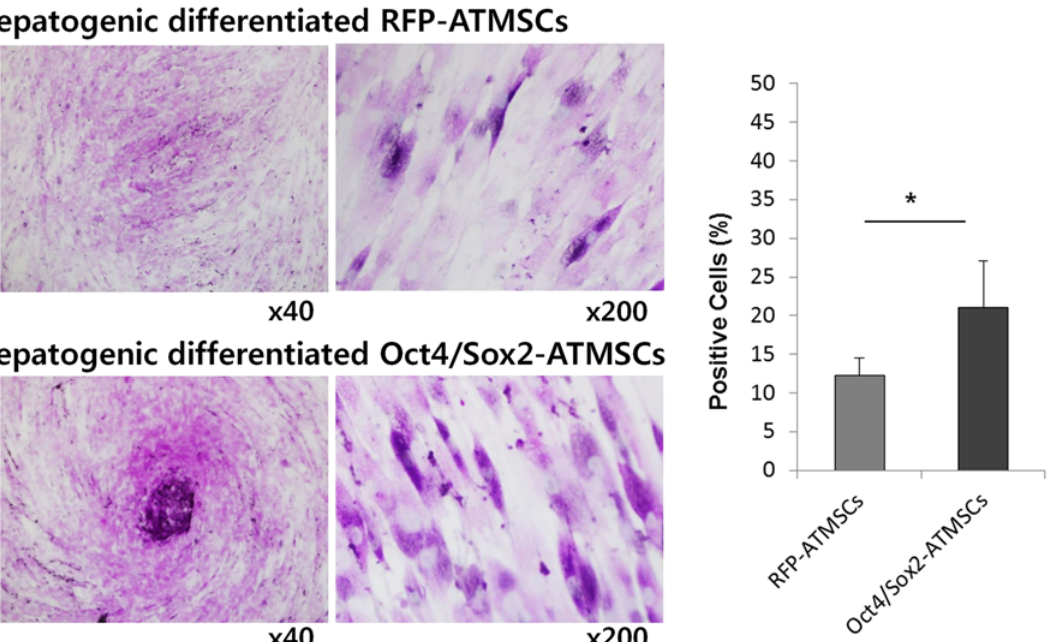
Fig 5. Period acid Schiff (PAS) staining of RFP- and Oct4/Sox2-ATMSCs after 28 days hepatogenic differentiation. (A) Detection of glycogen in the cytoplasm of MSCs subjected to the liver differentiation protocol was demonstrated by PAS staining. PAS-positive substances stain pink in the cytoplasm of cells. (B) The number of PAS-positive cells is expressed as percentage of the total number of counted cells and was significantly higher in Oct4/ Sox2-ATMSCs than that of RFP-ATMSCs. The experiments were repeated at least three times and similar findings were observed. Data represent the mean ± SD of three independent experiments. Statistical analysis was performed by student t -test (significant, * p < 0.05).